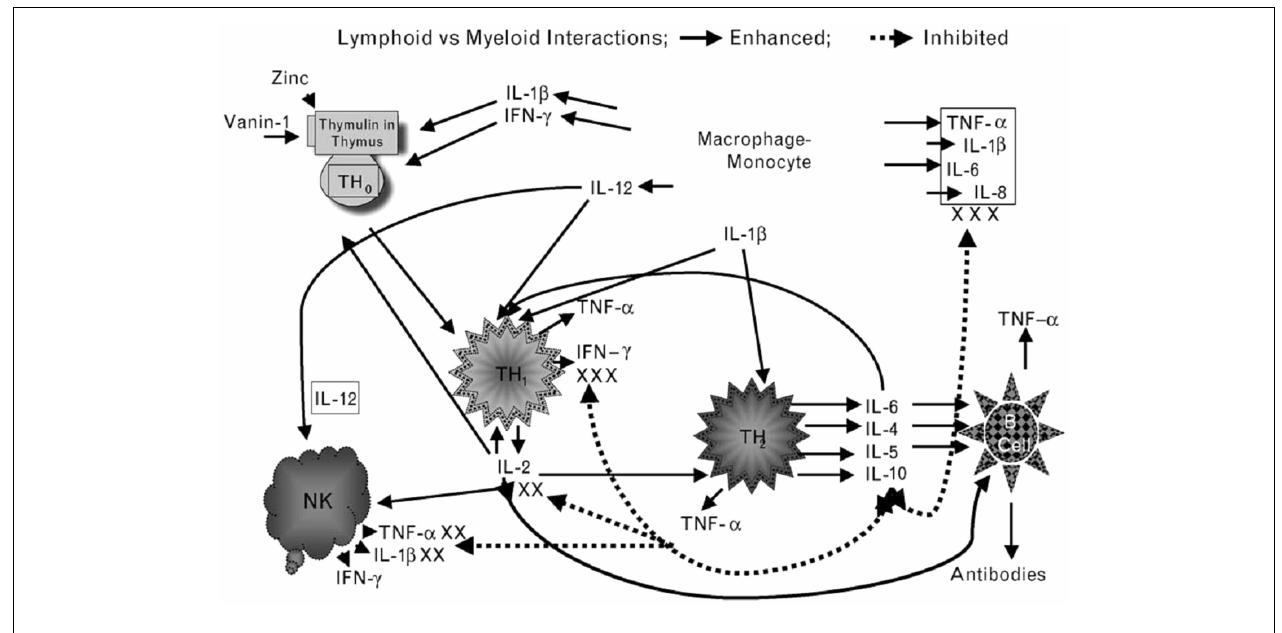
impaired. Zinc deficiency also leads to stress and activation of macrophages–monocytes, resulting in increased generation of inflammatory cytokines, IL-1 β , IL-6, IL-8, andTNF- α . Solid lines indicate pathways leading to generation of selected cytokines and dotted lines represent pathways, which lead to inhibition of cytokine generation. NK represent natural-killer cells;Th1 represent activatedTh1 typeT cells and secreted cytokines (small triangles);Th2 represents activatedTh2 typeT cells and secreted cytokines (small rounds); B-cell represents B-cell lineages and associated immunoglobulins (triangles). (Prasad, AS. Zinc: role in immunity, oxidative stress and chronic inflammation. Current Opinion